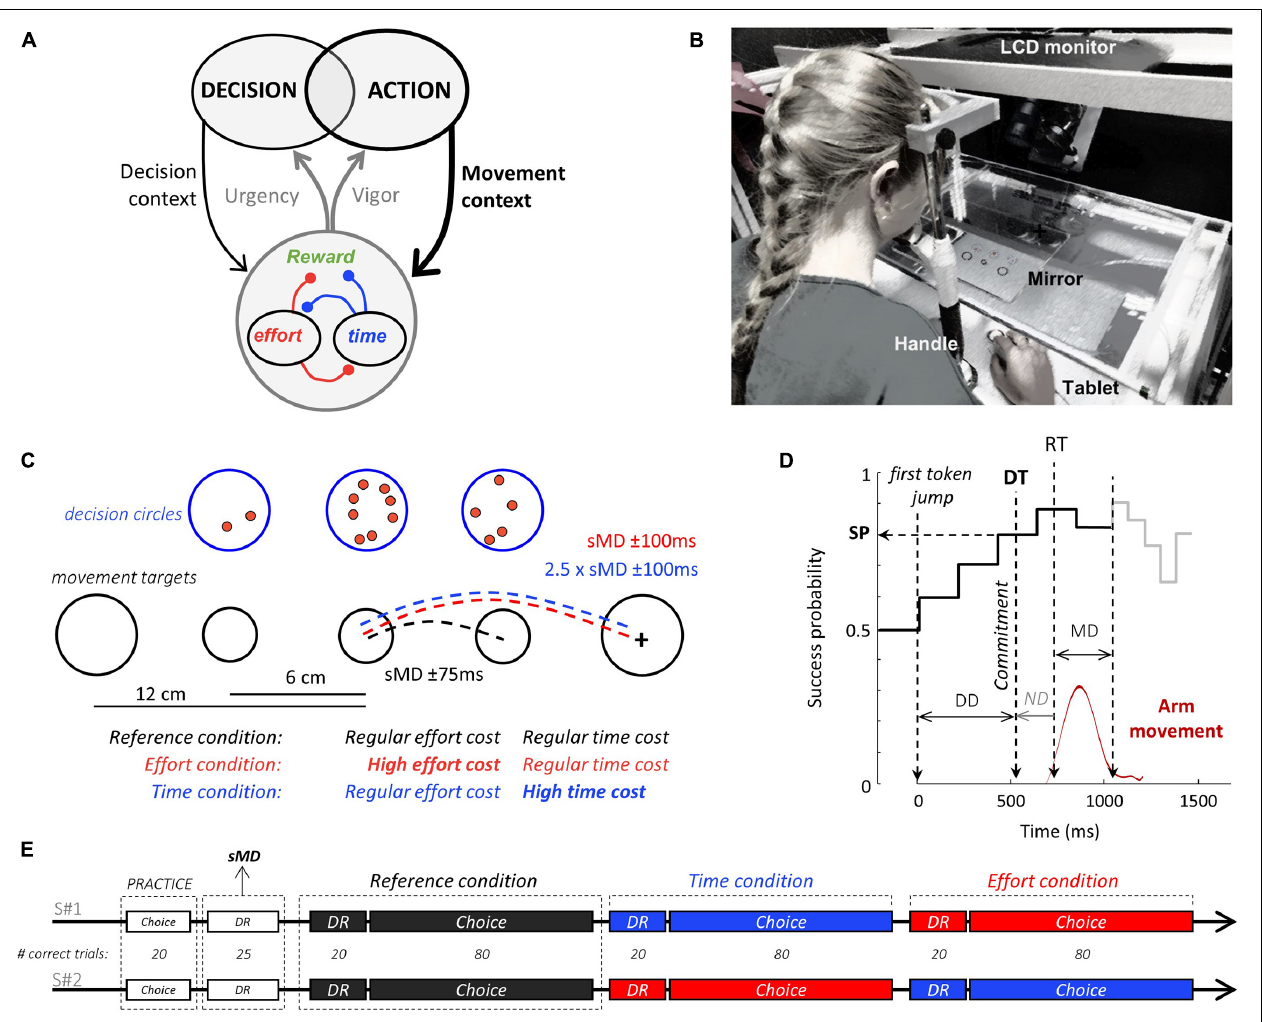
FIGURE 1 | Theoretical framework, experimental set-up and design. (A) To maximize the rate of reward during goal-directed behavior, decision and action must be coordinated. Regulation signals (gray arrows) allow such coordination. These signals are determined based on the decisional (thin black arrow) and motor (bold black arrow) context-dependent integration of reward value, elapsed time, and energy expenditure. These three components are intertwined in a trade-off of reciprocal negative interactions (red and blue connections). (B) Experimental apparatus (see text for details). (C) Visual display and motor conditions in the choice task. Blue circles illustrate the decision stimuli. Tokens successively jump from the central circle to one of the two lateral circles. Black circles show the movement stimuli. Subjects move a handle (cross) from a central start circle to one of the two lateral targets, depending on their choice. Movement amplitude and duration (MD) are imposed in distinct blocks of trials. In the Reference condition (black), both lateral movement targets are located close to the starting circle and a specific movement duration (with a 150 ms tolerance window) is imposed. In the two other conditions, both lateral movement targets are located twice as far apart from the starting circle compared to the Reference condition. In the Effort condition (red), the imposed movement duration is the same as in the Reference condition whereas in the Time condition (blue), the imposed movement duration is about twice longer. For these two costly conditions, the tolerance interval around the imposed movement duration is 200 ms. Note that four movement targets are displayed next to the start circle for illustration purpose. Only two, either at 6 or 12 cm of the starting circle are visible during the experiment. (D) Temporal profile of success probability in one example trial of the choice task. At the beginning of the trial, each target has the same success probability (0.5). When the first token jumps into one of the two potential targets (the most leftward vertical dotted line), success probability of that target increases to ∼ 0.6. Success probability then evolves with every jump. Subjects execute a reaching movement (red trace) to report their choices. Movement onset (RT) and offset times are used to compute movement duration (MD), and movement offset marks the moment when the tokens that remain in the central decision circle jump more quickly to their assigned target (gray trace). The estimated time of the decision (DT) is computed by subtracting the subject’s mean non-decision delay (ND) estimated in a simple delayed-reach (DR) task from movement onset time, allowing computation of the success probability (SP) at that moment. Only 10 out of 15 jumps are illustrated on this SP profile. (E) Time course of the two sessions (S#1 and S#2). Subjects start each session with 20 trials of the choice task to familiarize themselves with the set-up. Then 25 trials of the DR task with no constraint on movement duration are performed in order to determine for each subject the average spontaneous arm movement duration (sMD) which will be necessary to determine the time constraints of the response movements in each condition. Subjects next need to complete 20 correct trials in the DR task and 80 correct trials in the choice task for each motor condition. They start with the Reference condition, followed by the Time and the Effort conditions in the first session. The order of presentation of the two costly conditions is reversed in the second